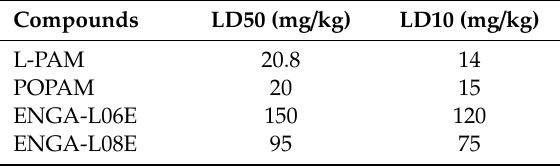
Table 2. Acute toxicity of the compounds L-PAM, POPAM, ENGA-L06E, ENGA-L08E in CB17 SCID mice, where LD 50 and LD 10 are the lethal doses for 50% and 10% of the treated mice population. Compounds LD50 (mg /